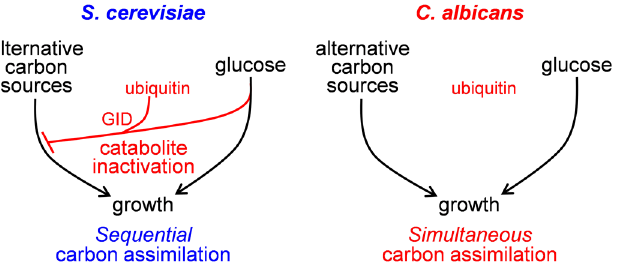
Fig 1. The lack of catabolite inactivation in C . albicans permits simultaneous assimilation of alternative carbon sources and glucose. In S . cerevisiae , glucose triggers the rapid ubiquitination and degradation via the GID complex of enzymes involved in the assimilation of alternative carbon sources (catabolite inactivation). Consequently, S . cerevisiae displays sequential assimilation of these carbon sources, only utilizing alternative carbon sources once glucose has been exhausted. In contrast, C . albicans enzymes involved in the utilization of alternative carbon sources lack ubiquitination sites and hence are not subject to catabolite inactivation. Consequently, these pathways remain active in C . albicans following glucose exposure and this yeast displays simultaneous assimilation of alternative carbon sources and glucose